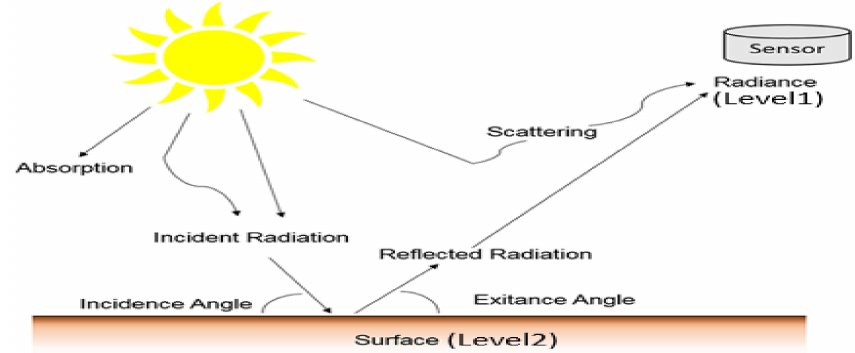
Figure 1. Illustration of the top of the atmosphere (Level 1) reflectance and bottom of atmosphere (Level 2) surface reflectance product